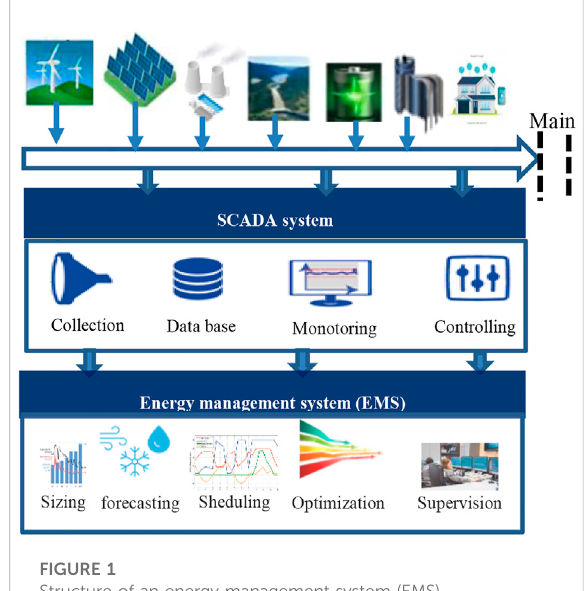
FIGURE 1 Structure of an energy management system